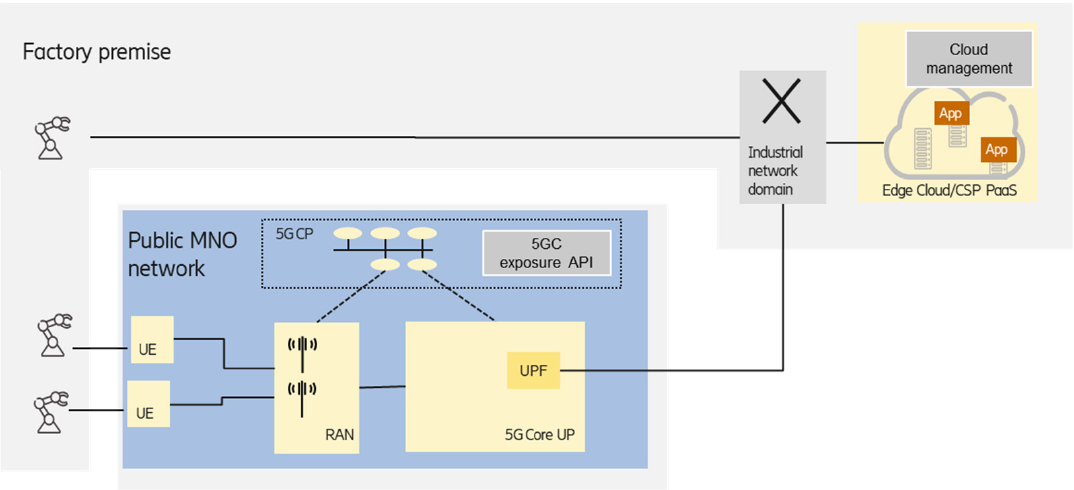
Figure 7. On-premises factory edge with PNI-NPN.